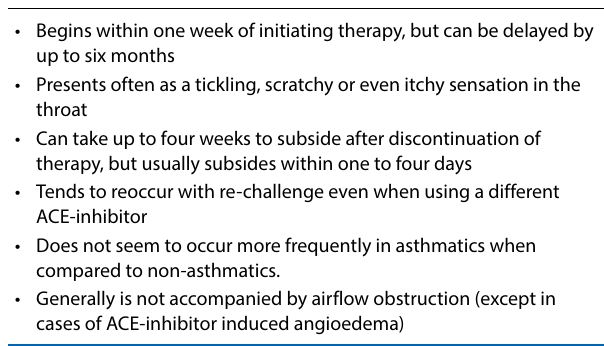
Table 1: General feature of ACE-inhibitor induced coughs